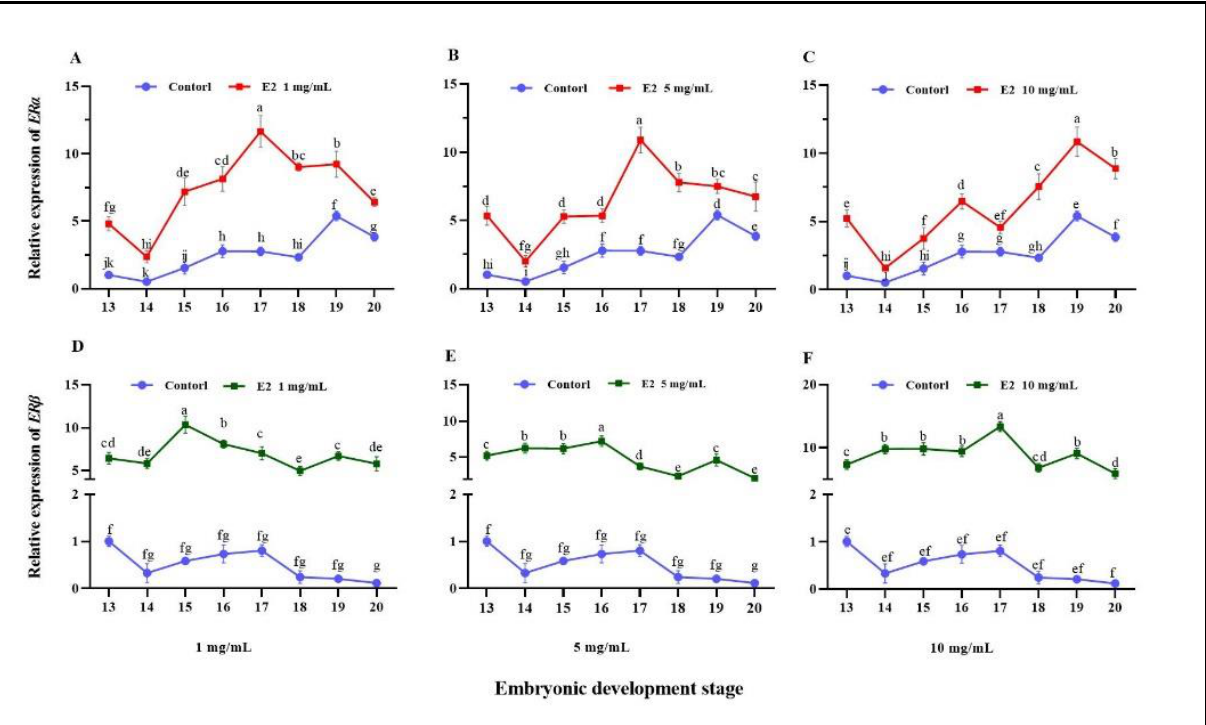
Figure 4. Expression of ERs in E2-treated male embryos at embryonic development stages after injection with different concentrations of E2. Data are the mean ± SD (n = 3). Different letters indicate significant differences between the control group and the experimental group, respectively ( P < 0.05): ( A ) ERα for 1 mg/mL E2; ( B ) ERα for 5 mg/mL E2; ( C ) ERα for 10 mg/mL E2; ( D ) ERβ for 1 mg/mL E2; ( E ) ERβ for 5 mg/mL E2; and ( F ) ERβ for 10 mg/mL E2.